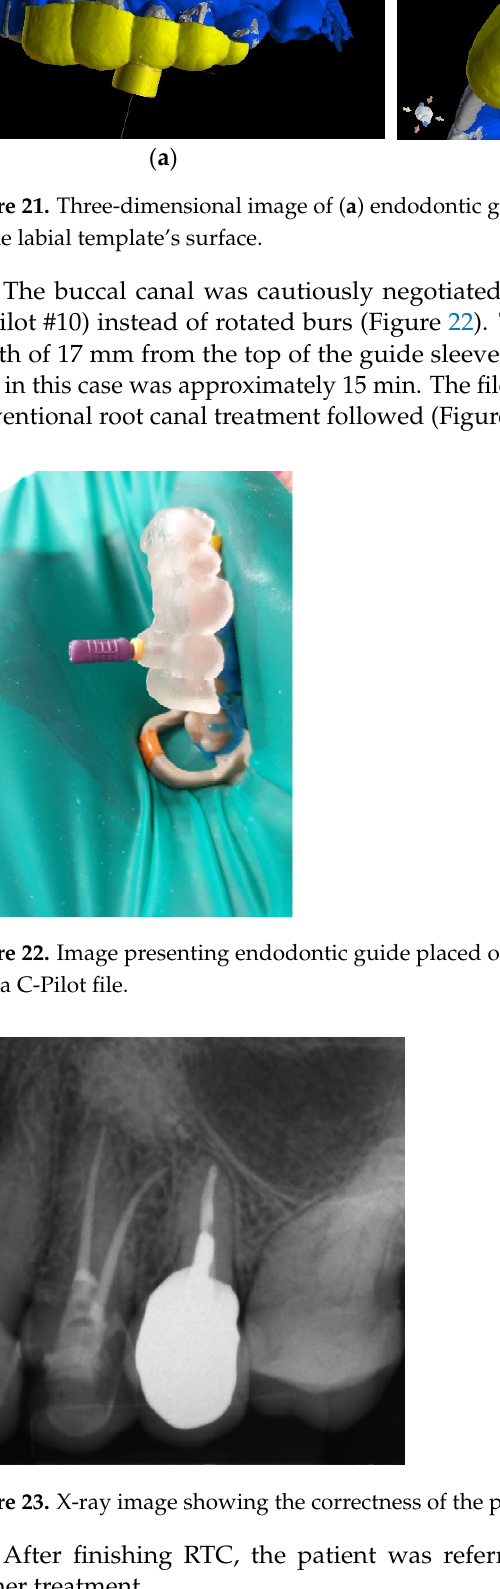
Figure 20. CBCT image presenting ( a ) virtual implant positioned through the centre of the buccal root, preserving a safe amount of the tooth’s hard tissues; ( b ) guide tube designed to reach the bot- tom of the chamber after 15.5 mm. In the lateral dentition area, short guide tubes may ensure more space for the drill.